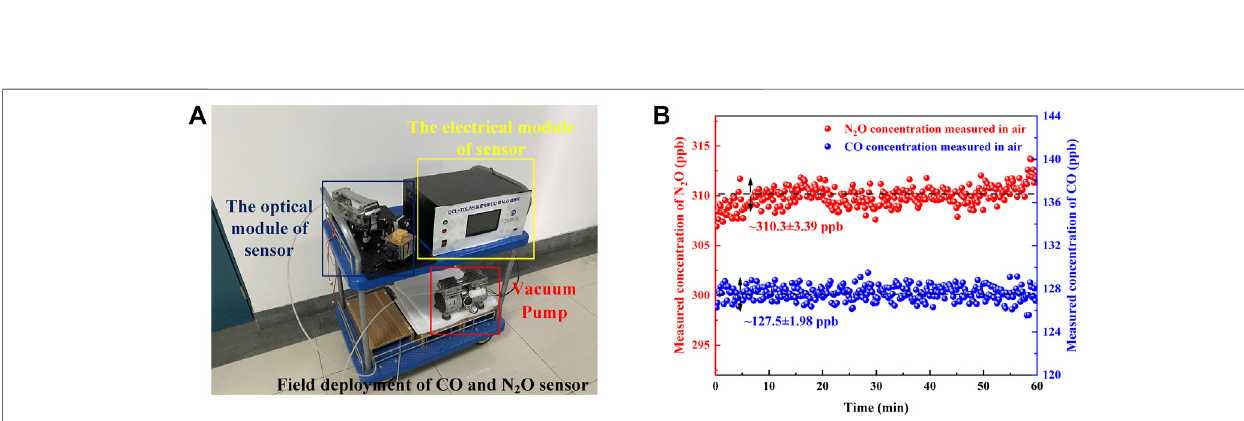
Frontiers in Chemistry |